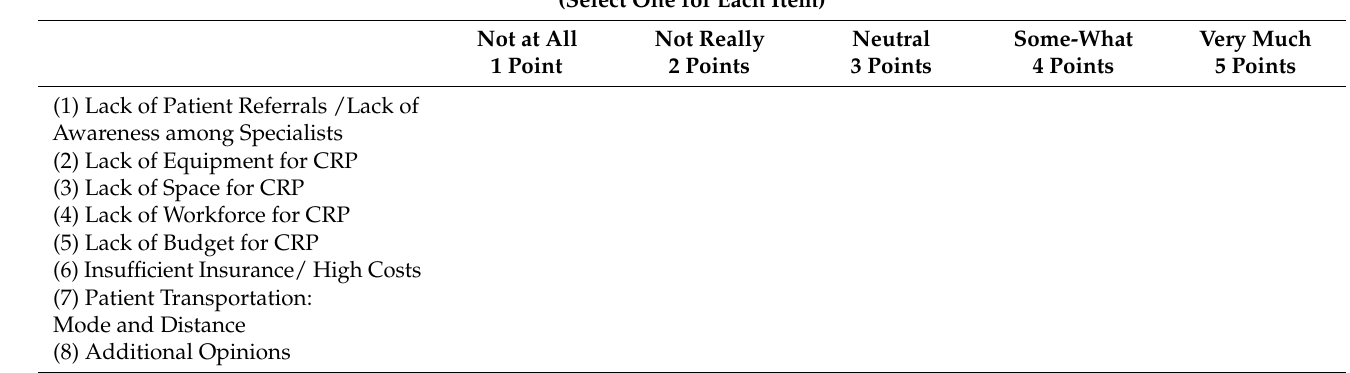
Table 1. The assessment checklist’s questions for identifying barriers and investigating the imple- mentation status of cardiac rehabilitation.